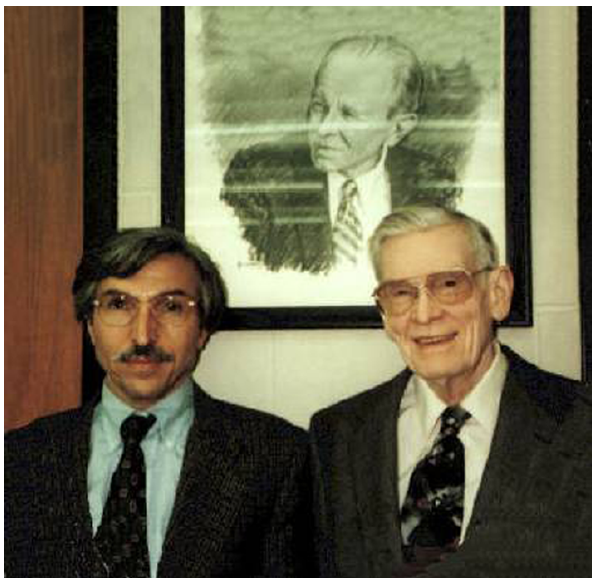
Figure 2. Gholamreza Mesri and Ralph B. Peck in front of a portrait of Terzaghi. Source: Ralph B. Peck Family. All rights reserved.